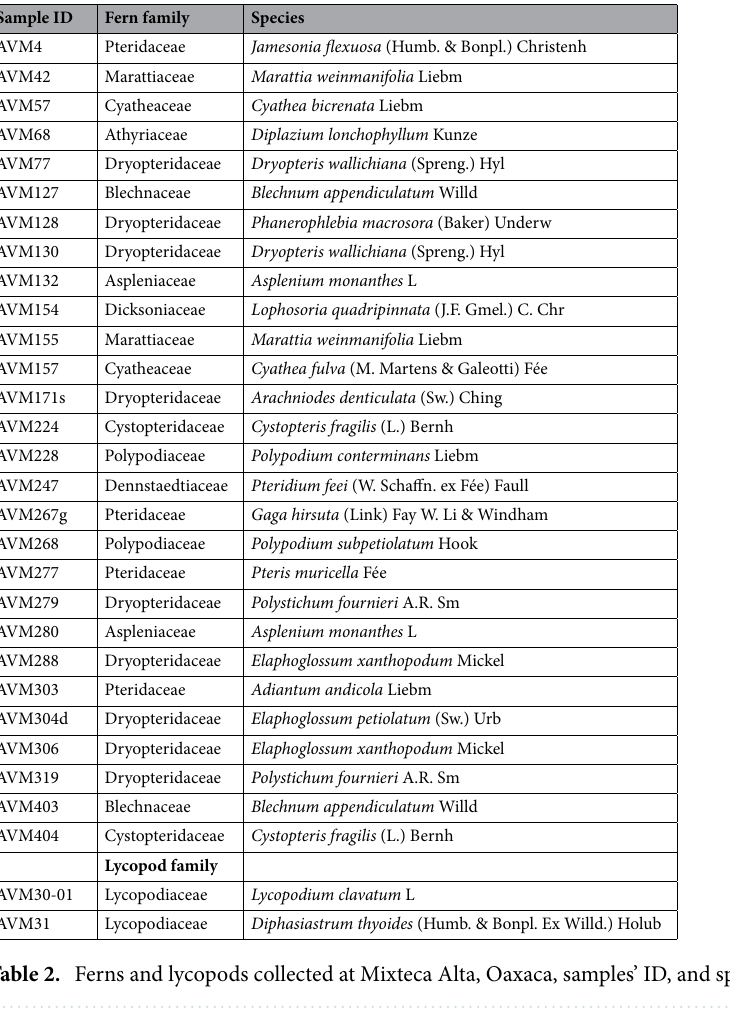
Amplification success